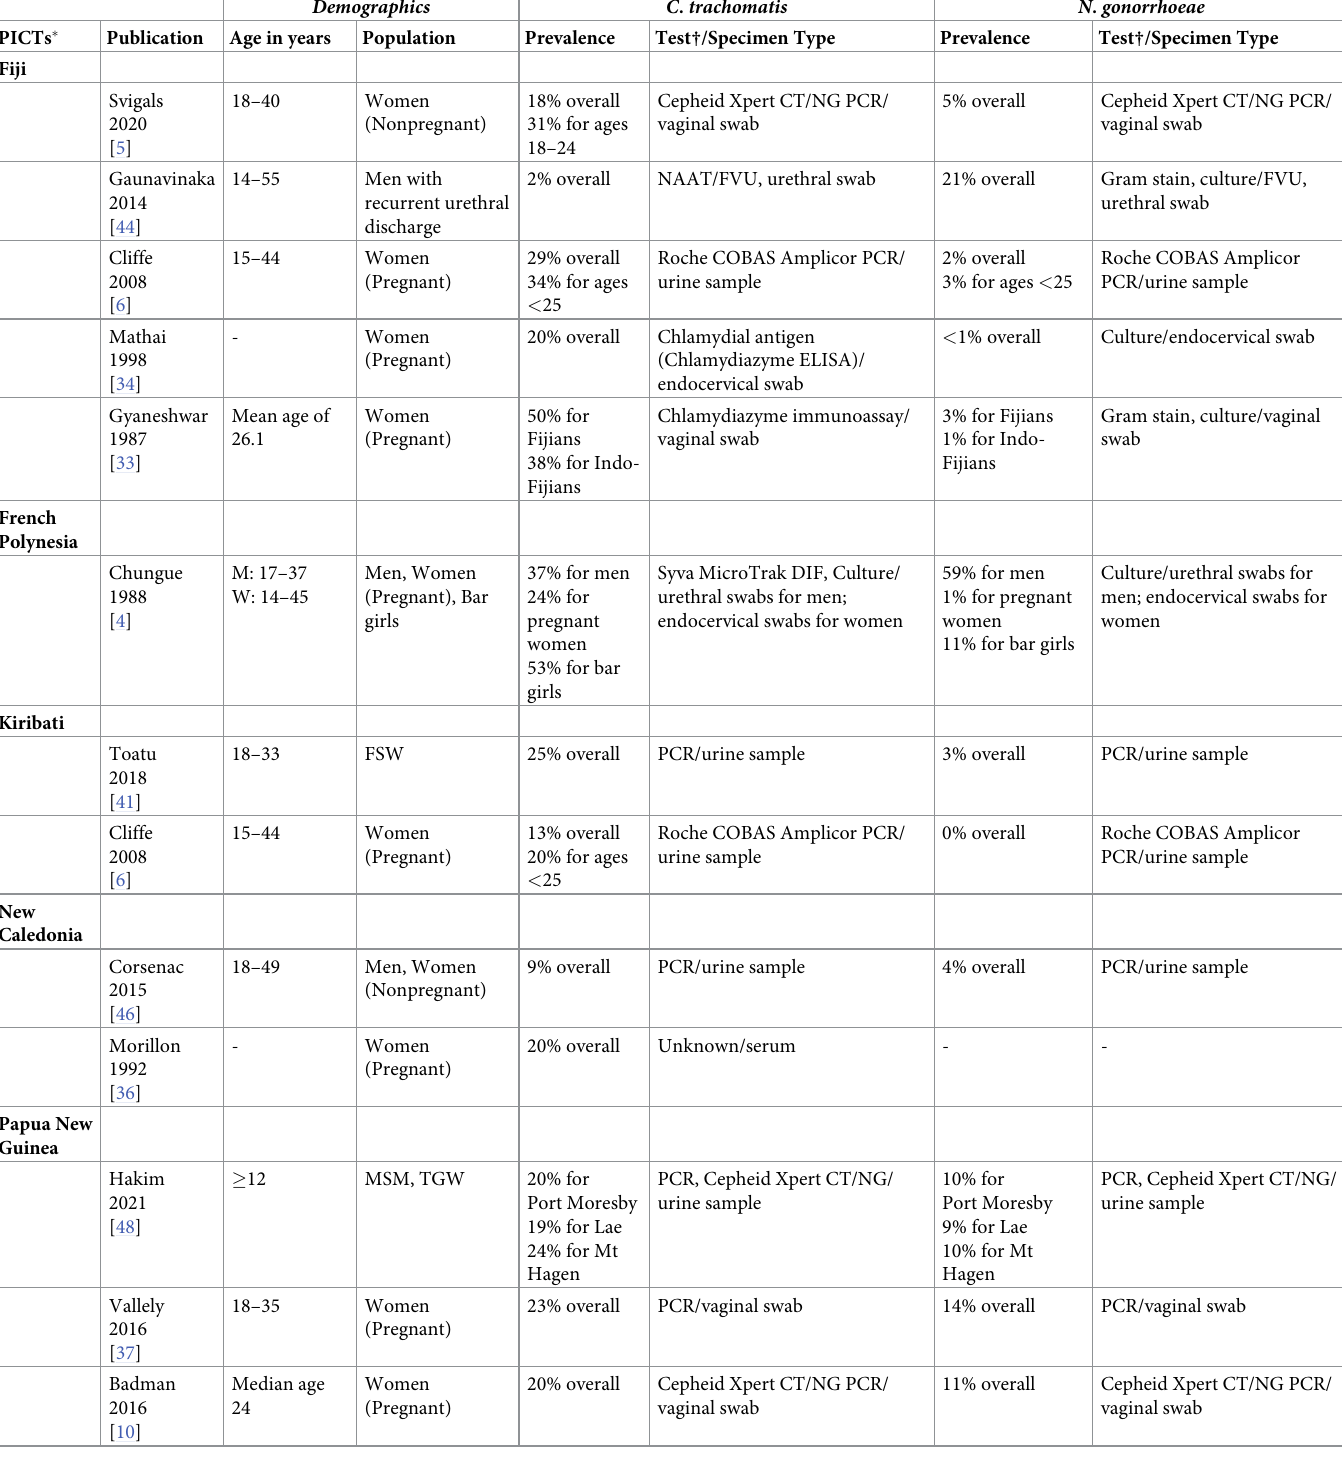
Table 1. Original research publications on sexually transmitted C . trachomatis and N . gonorrhoeae infections in